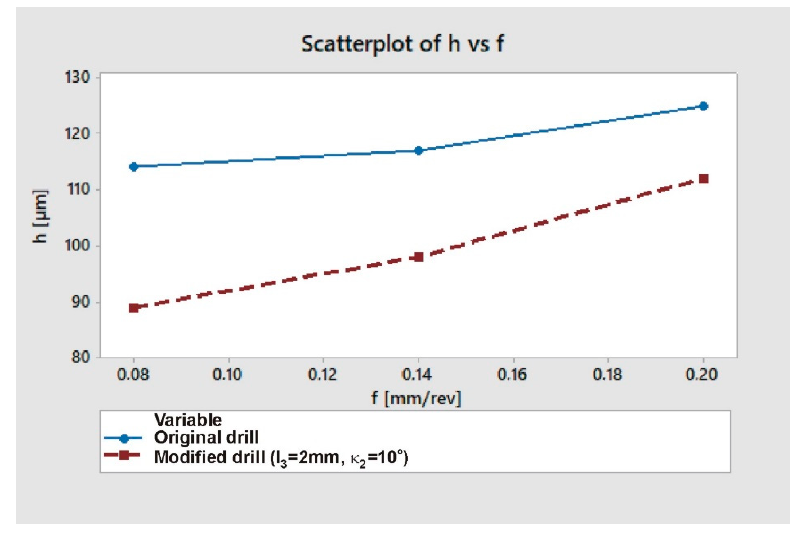
Figure 11. Burr height h as a function of feed f for factory and modified drills.